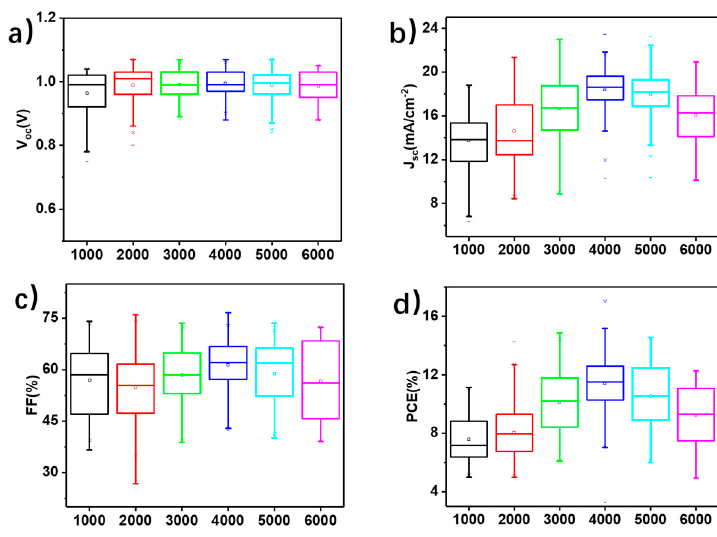
Figure 3. Comparison of the PSCs with CIGS thin films spin-coated at different speeds. Statistics for ( a ) V oc , ( b ) J sc , ( c ) FF , and ( d ) PCE.